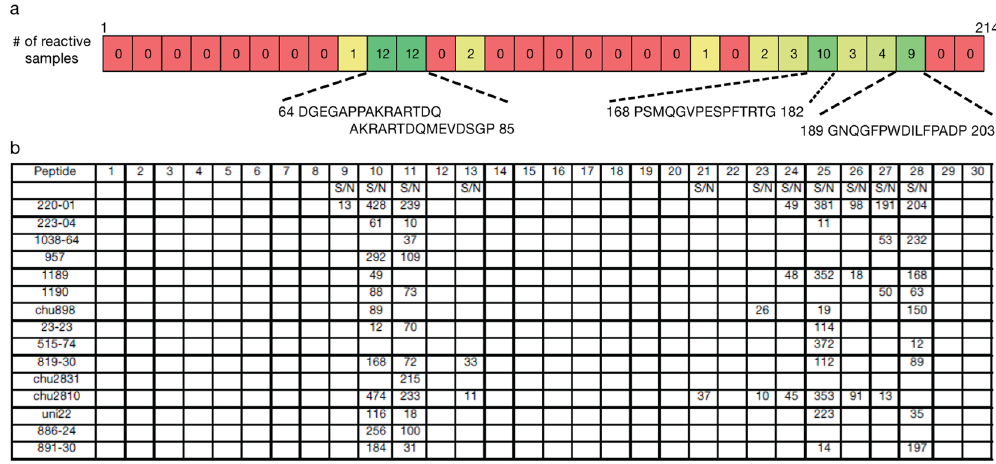
Figure 5. Linear epitopes identified using HDV large antigen scanning peptides. ( A ) Heat map analysis of reactivity of HDV RNA positive samples (n = 15) tested with individual scanning peptides in an indirect IgG assay. Indicated are the number of reactive samples for each scanning peptide and the amino acid residues of reactive peptides 10, 11, 25, and 28. Refer to Fig. 3 for complete amino acid sequence used in the peptide scan. ( B ) Shown only are S/N values ≥ 10; considered